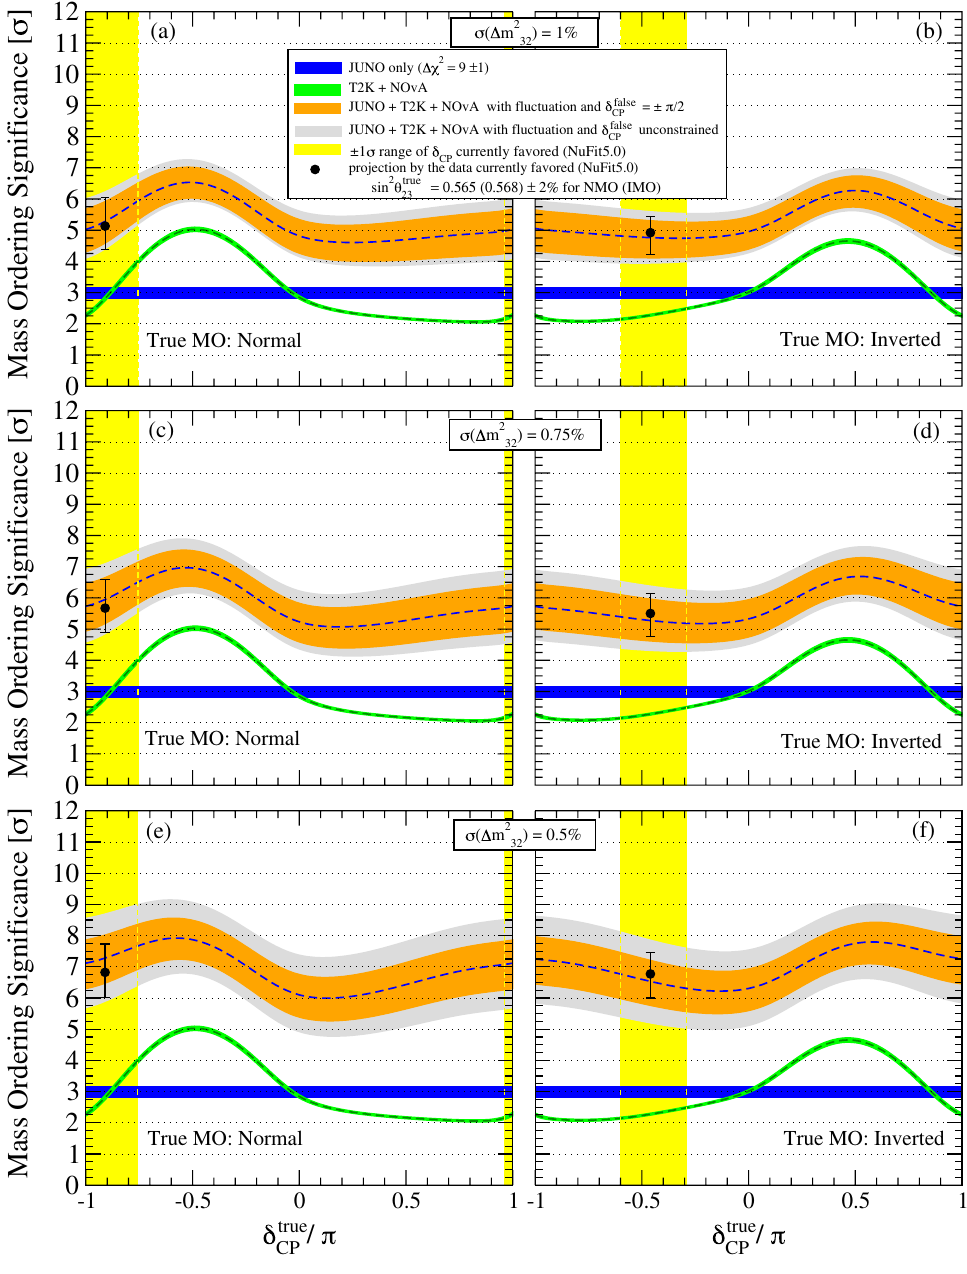
Figure 6. The combined mass ordering sensitivity. The combination of the MO sensitive of JUNO and LB ν B-II is illustrated for six difference configurations: NMO (left), IMO (right) considering the LB ν B uncertainty on (cid:31) m 2 32 to 1.0% (top), 0.75% (middle) and 0.5% (bottom). The NuFit5.0 favoured value is set for sin 2 θ 23 with an assumed 2% experimental uncertainty. The intrinsic MO sensitivities are shown for JUNO (blue) and the combined LB ν B-II (green), the latter largely dominated by NOvA. The JUNO sensitivity boosts when exploiting the LB ν B’s (cid:31) m 2 32 additional information via the �χ 2 BOOST term, described in Fig. 4 but not shown here for illustration simplicity. The orange and grey bands illustrate the presence of the boosting term prediction effects, respectively, the ± 1 σ fluctuation of (cid:31) m 2 32 and the δ CP ambiguity in addition. T2K impacts mainly via the precision of (cid:31) m 2 32 and the measurement of δ CP . The combined sensitivity suggests a mean (dashed blue line) ≥ 4 σ significance for any value of δ CP even for the most conservative σ(� m 2 ) = 1%. However, a robust ≥ 5.0 σ 32 significance at 84% probability (i.e. including fluctuations) seems possible, if the currently preferred value of δ CP and NMO remain favoured by data, as indicated by the yellow band and black point (best fit). Further improvement in the precision of (cid:31) m 2 32 translates into a better MO resolution